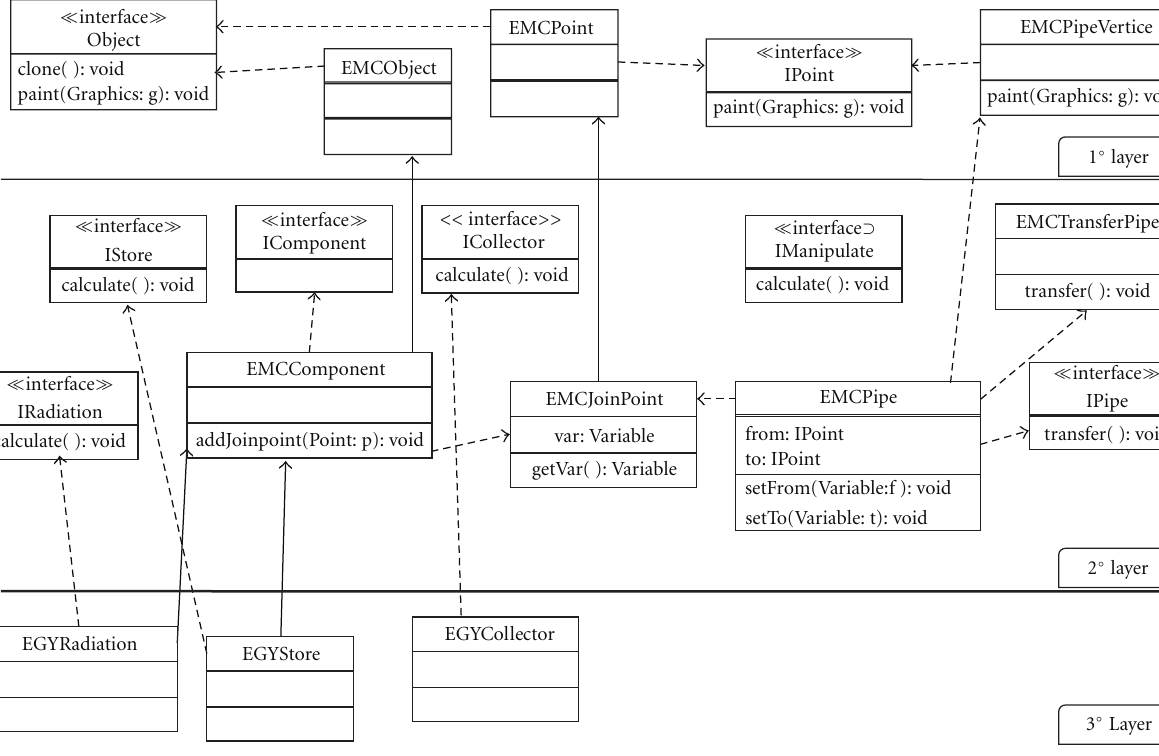
Figure 3: Main classes of the SolarEnergy